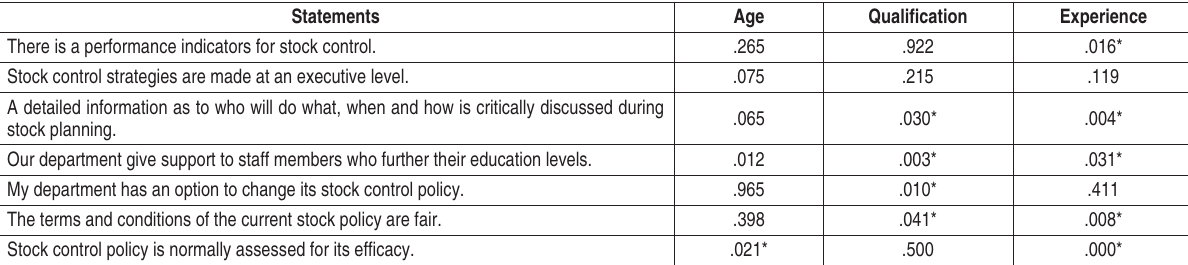
Table 6 (cont.). The results of the Chi square